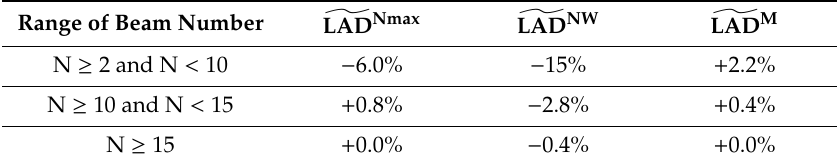
Table 2. Mean biases (in % of the mean LAD ref ) of the three estimators for three di ff erent classes of total beam number N .